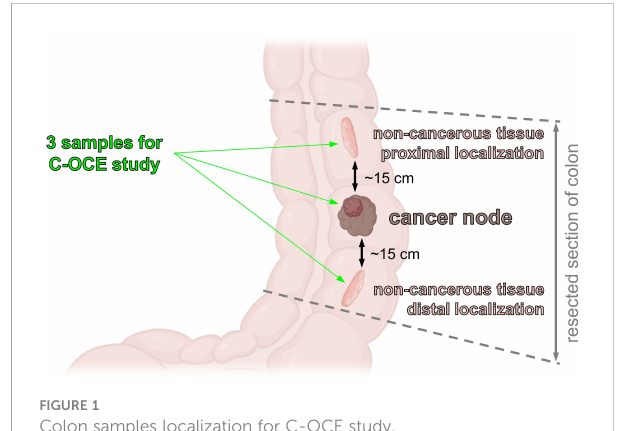
FIGURE 1 Colon samples localization for C-OCE